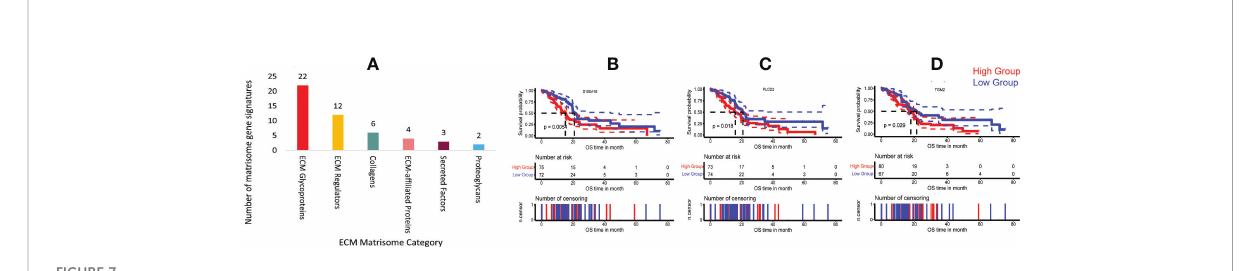
FIGURE 7 Correlation of PLAU expression and matrisome gene signatures in human PDAC. (A) Upregulation of PLAU gene expression was positively correlated with various PDAC ECM matrisome gene signatures. Kaplan Meier survival curves show that in the TCGA-PDAC cohort, poor survival was associated with (B) increased expression of S100A16 , P = 0.0054, (C) PLOD2 , P = 0.018 and (D) TGM2 ,